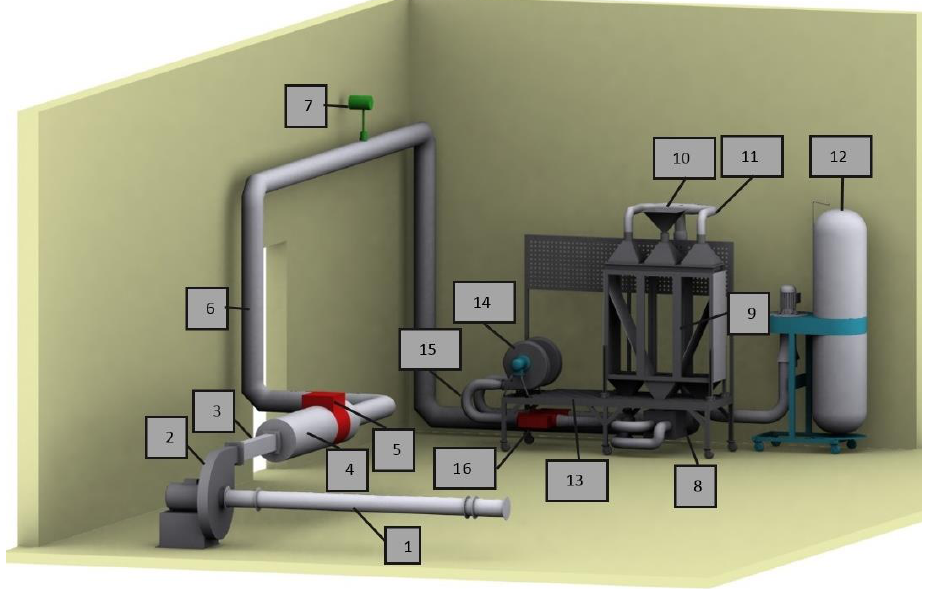
Figure 3. Visualization of the technological system of the three-dimensional (3D) installation.